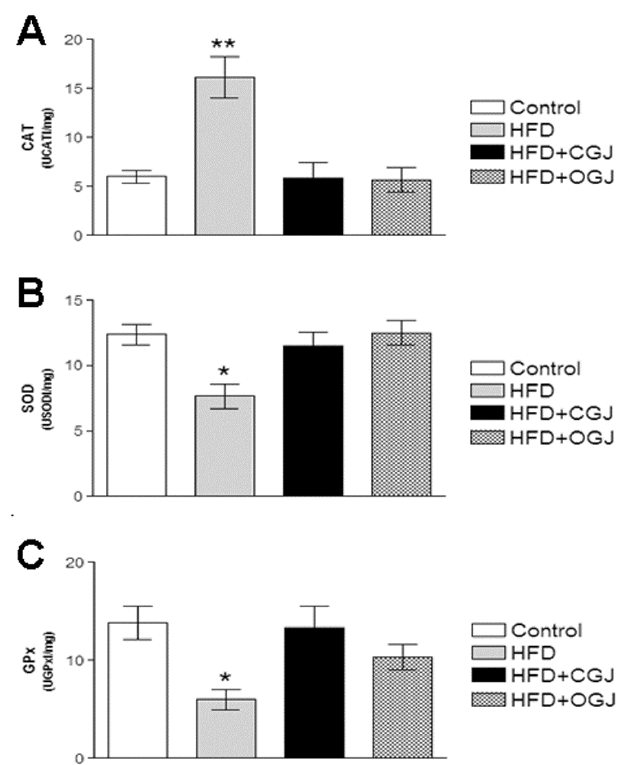
Figure 3. The effect of purple grape juices and high-fat diet on the activities of the antioxidant enzymes catalase (CAT) ( A ), superoxide dismutase (SOD) ( B ) and glutathione peroxidase (GPx) in the liver of rats. Values are means ± SD for 8–10 samples in each group. Statistically significant differences were determined by ANOVA followed by the